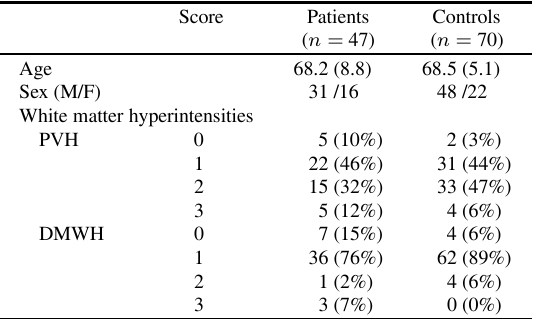
Table 2 White matter hyperintensities in TEA patients and healthy